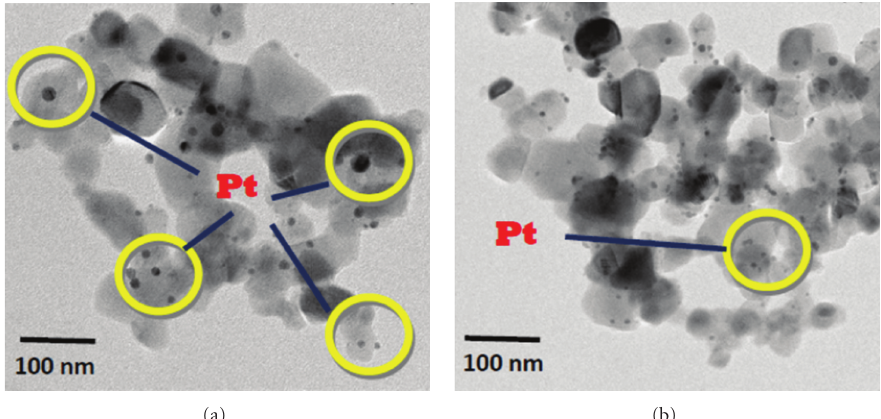
Figure 3: The TEM images of the Img: Pt-ZnO-SiO 2 (a) and PAD: Pt-ZnO-SiO 2 (b) catalysts.